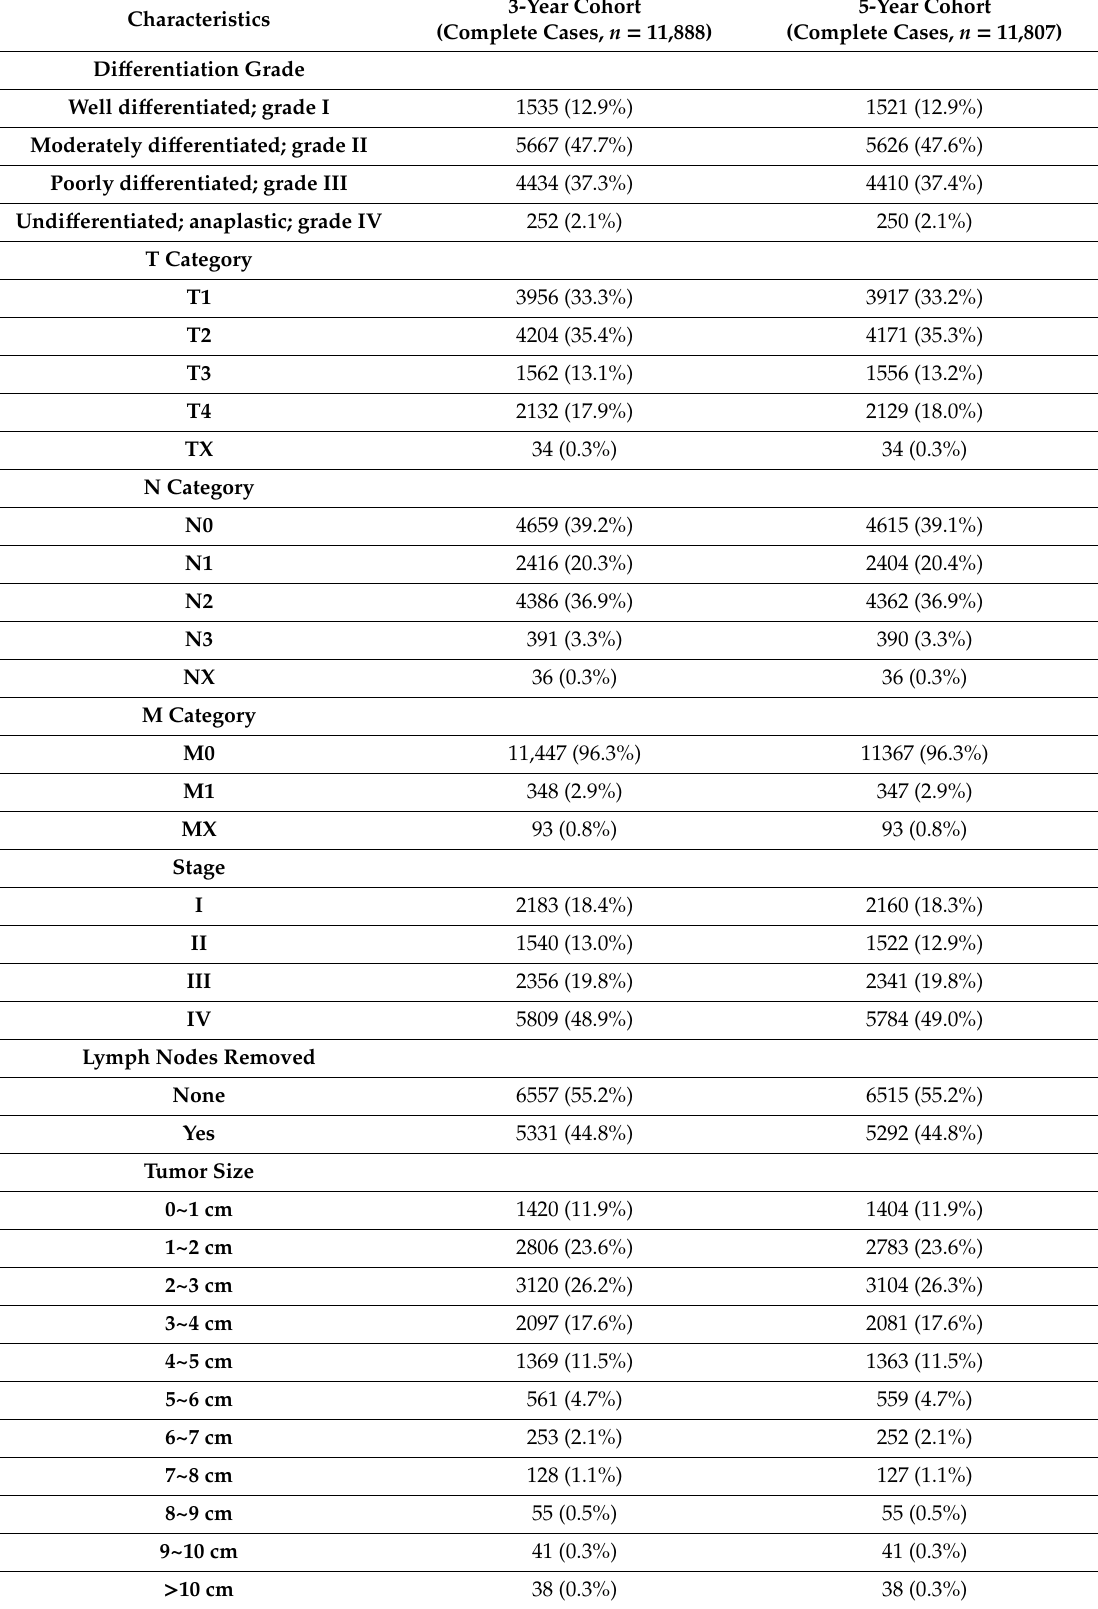
Table 2. Tumor-related characteristics of patients with oral and pharyngeal cancers in SEER